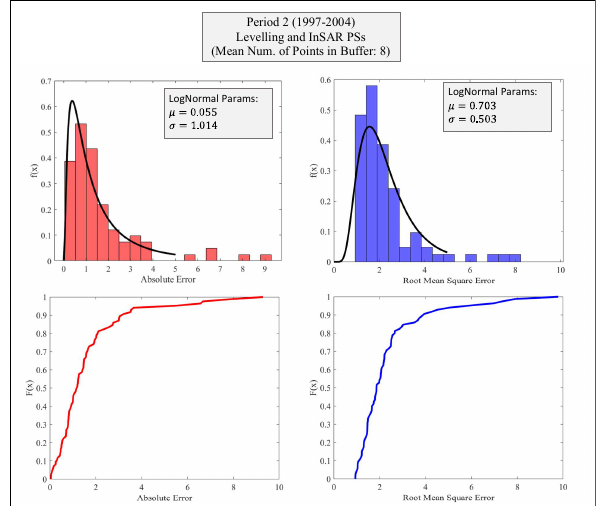
Figure 7. Statistical Assessment using AE and RMSE: optical levelling measurements and InSAR PSs in the period 1997-